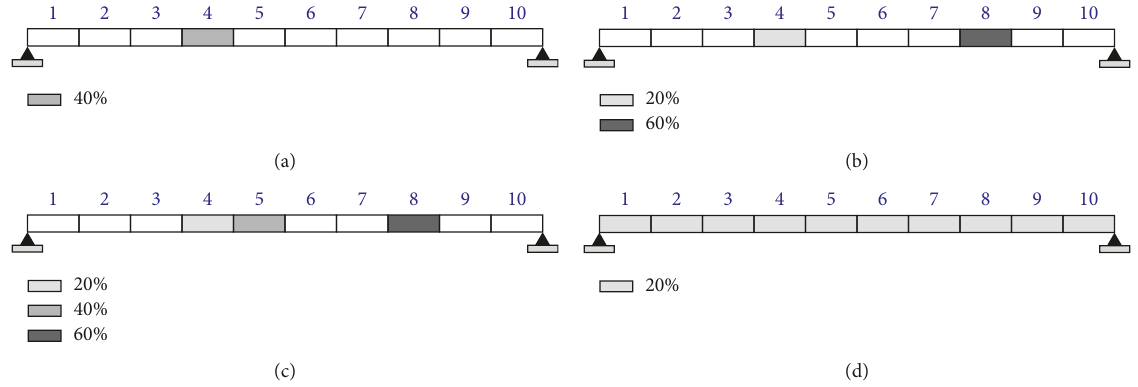
Figure 2: Beam example: first four eigenmodes of the undamaged structure. (a) Eigenmode 1 ( T (c) eigenmode 3 ( T 3 0.013s), and (d) eigenmode 4 ( T 4 (cid:31)